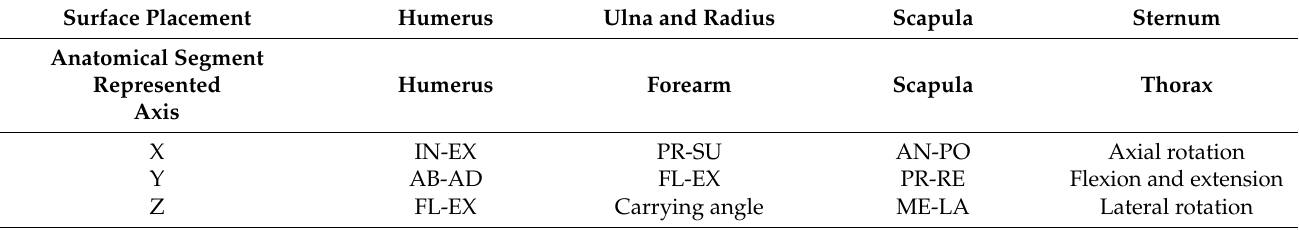
Table 1. Equivalence of the yaw, pitch and roll with the movement that they represent. Surface